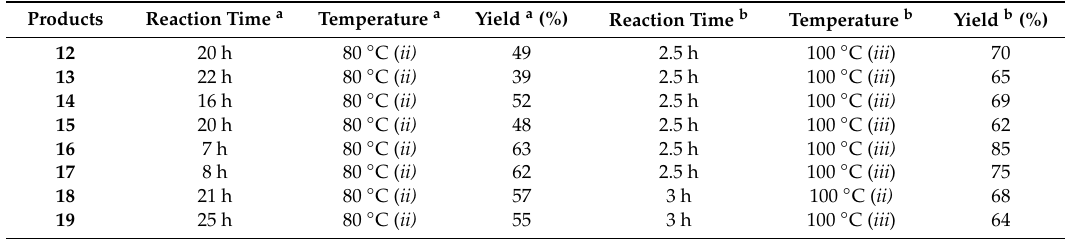
Table 2. Reaction conditions for the synthesis of the azaindoles 12 –